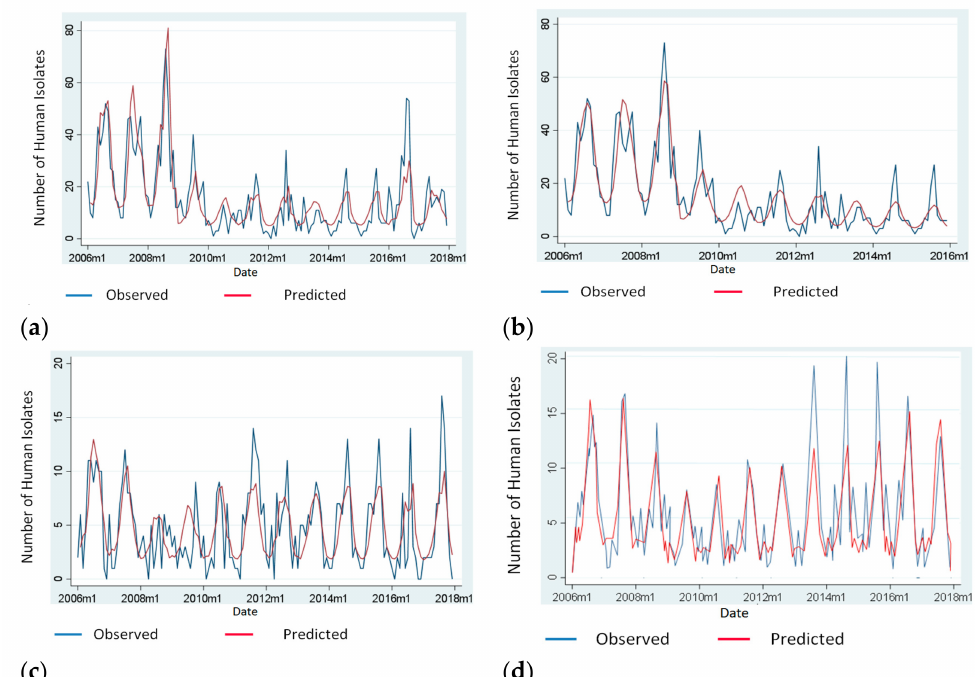
Figure 2. Number of observed and predicted human Salmonella isolates, Greece, 2006–2017; ( a ) Num- ber of observed and predicted human S. Enteritidis isolates according to the model used, Greece, 2006–2017; ( b ) Number of observed and predicted human S. Enteritidis isolates according to the model used, Greece, 2006–2015 (For S. Enteritidis , a sensitivity analysis was also performed for both periods 2006–2017 and 2006–2015. The reason was that in 2016 there was an excess in the number of S. Enteritidis cases in Greece probably attributed to the multi-country S. Enteritidis outbreak re- lated to the consumption of infected Polish eggs); ( c ) Number of observed and predicted human S. Typhi-murium isolates according to the model used, Greece, 2006–2017; ( d ) Number of observed and predicted human isolates attributed to “Control Salmonella serotypes” (serotypes detected from human cases between 2004 and 2017, but were either not detected or rarely detected, the maximum of two times each, in poultry) according to the model used, Greece,